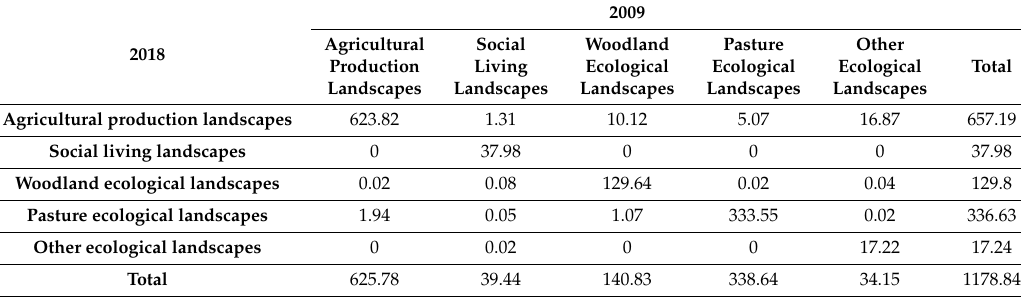
Table 5. Transfer matrix of SEPLs in Mizhi county from 2009 to 2018 / km 2